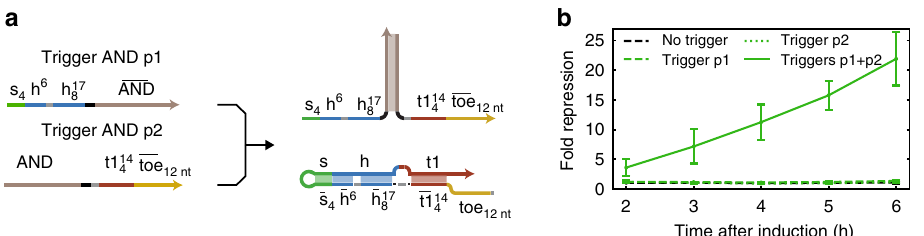
Fig. 6 Multi-input SD gRNAs in E. coli . a Design of a trigger AND gate for the activation of SD gRNAs (version C). b Repression of mVenus at different time points after the induction of dCas12a for the trigger AND gate (black dashed line: no trigger, green dashed line: trigger p1, green dotted line: trigger p2, solid green line: triggers p1 + p2), ( N = 4, t -distribution two-sided 90% con fi dence interval). Source data are provided as a Source Data